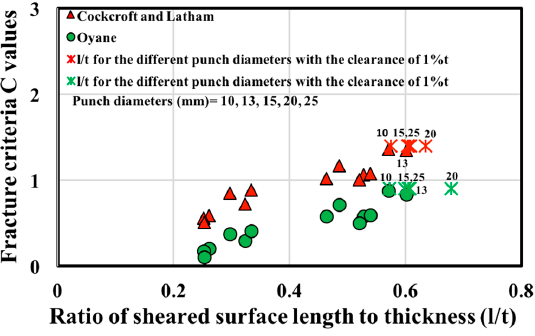
Figure 12. Relationships between the values of fracture criteria and ratio of sheared surface length to thickness predicted by the punch diameters of 10, 13, 15, 20, and 25 mm for the clearance of 1 %t.